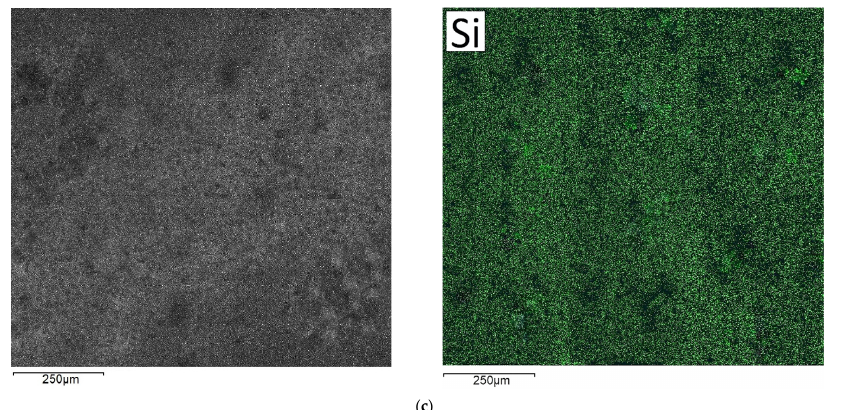
Figure 4. Electronic microphotography of clean aluminium surface and Al with organosilane films formed after 60 min of exposure to the modifying solution and the distribution of Si on the modified samples: ( a ) clean Al; ( b ) DAS; ( c ) VS.